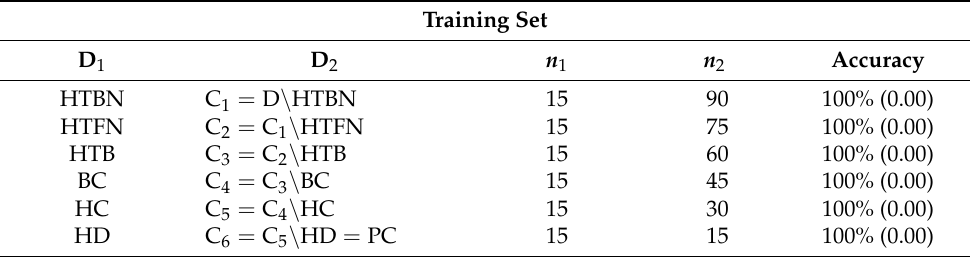
Figure 5. Flowchart of the two-stage procedure at N i , i = 2, . . . ,6, where C i is defined in Table 1, F i denotes the stage of filtering extremely aberrant observations, and RF i denotes the random forest classifier. Table 1. Classification accuracies and corresponding standard deviations of the training sets at the six nodes in Figure 4.